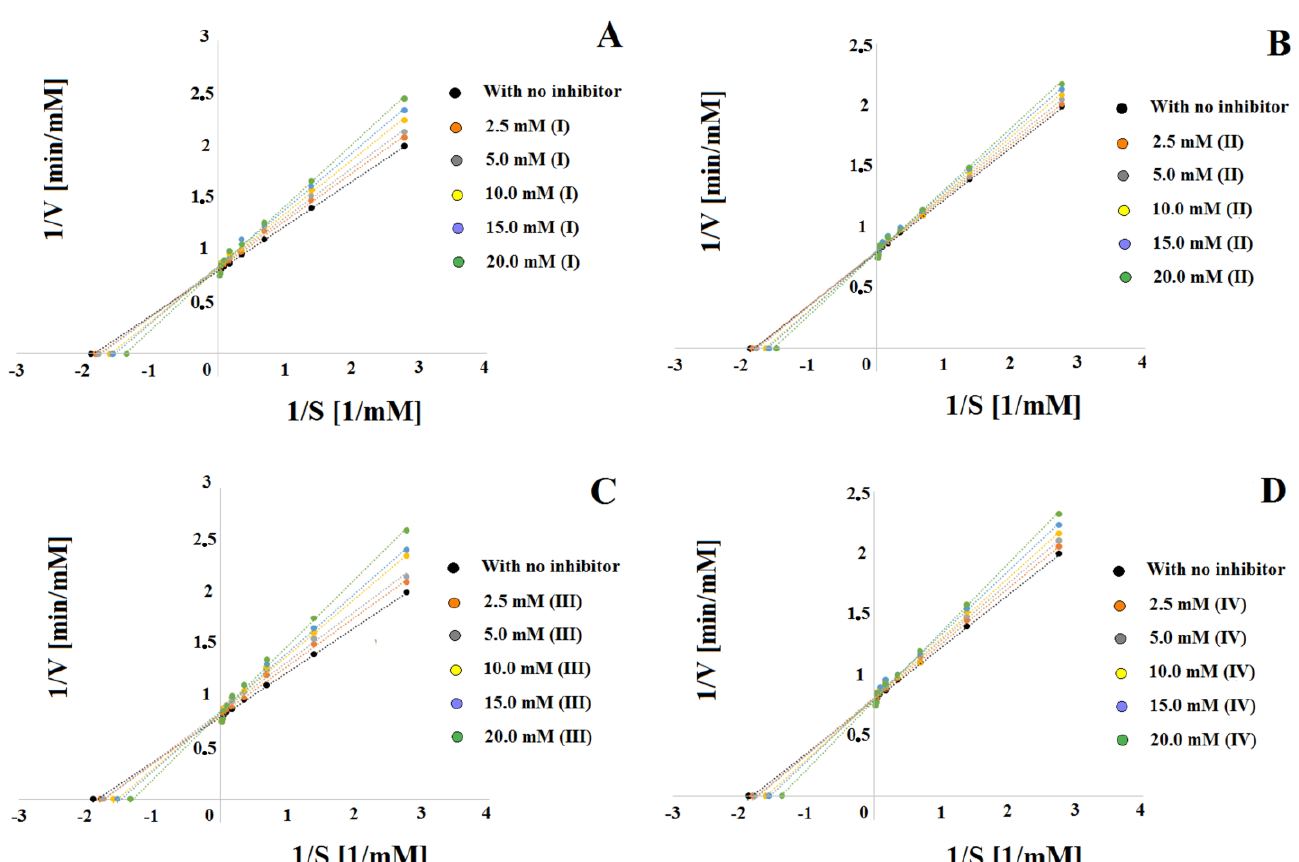
Figure 3. Lineweaver–Burk plots for systems with inhibitors (I) ( A ), (II) ( B ), (III) ( C ) and (IV) ( D ) at concentrations of 2.50, 5.00, 10.00, 15.00 and 20.00 mM.